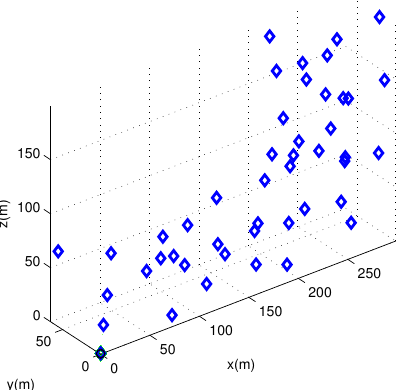
Figure 9. The ARs’ final locations under our formation controls (Algorithm 1) for covering the user-specified complicated shape ( r sc = 50